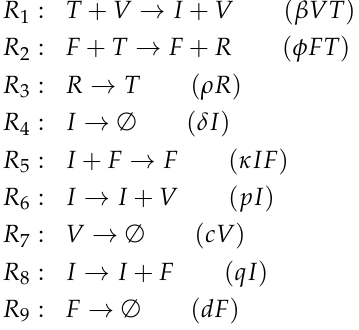
Figure A4. Reactions of Pawelek model [23].